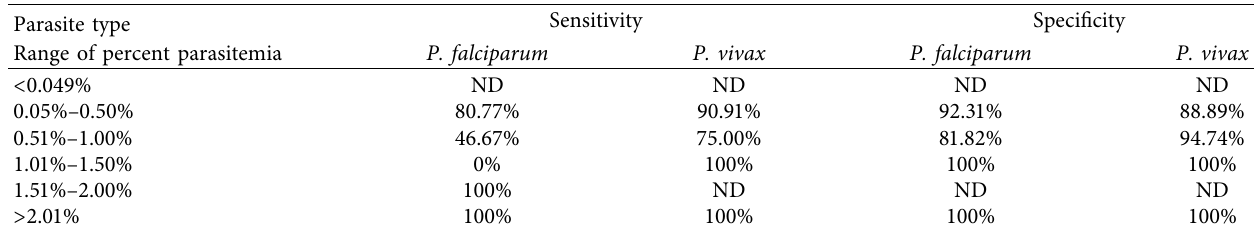
Table 6: Sensitivity and specificity of Care Start ™ Malaria Pf/Pv Combo test for the diagnosis of malaria species infections at different levels of percent parasitemia, Arba Minch,